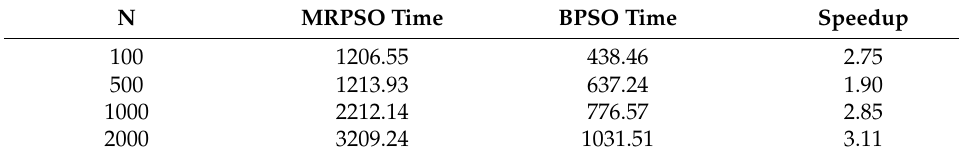
Table 3. MRPSO and BPSO running time and speedup on f 2 .